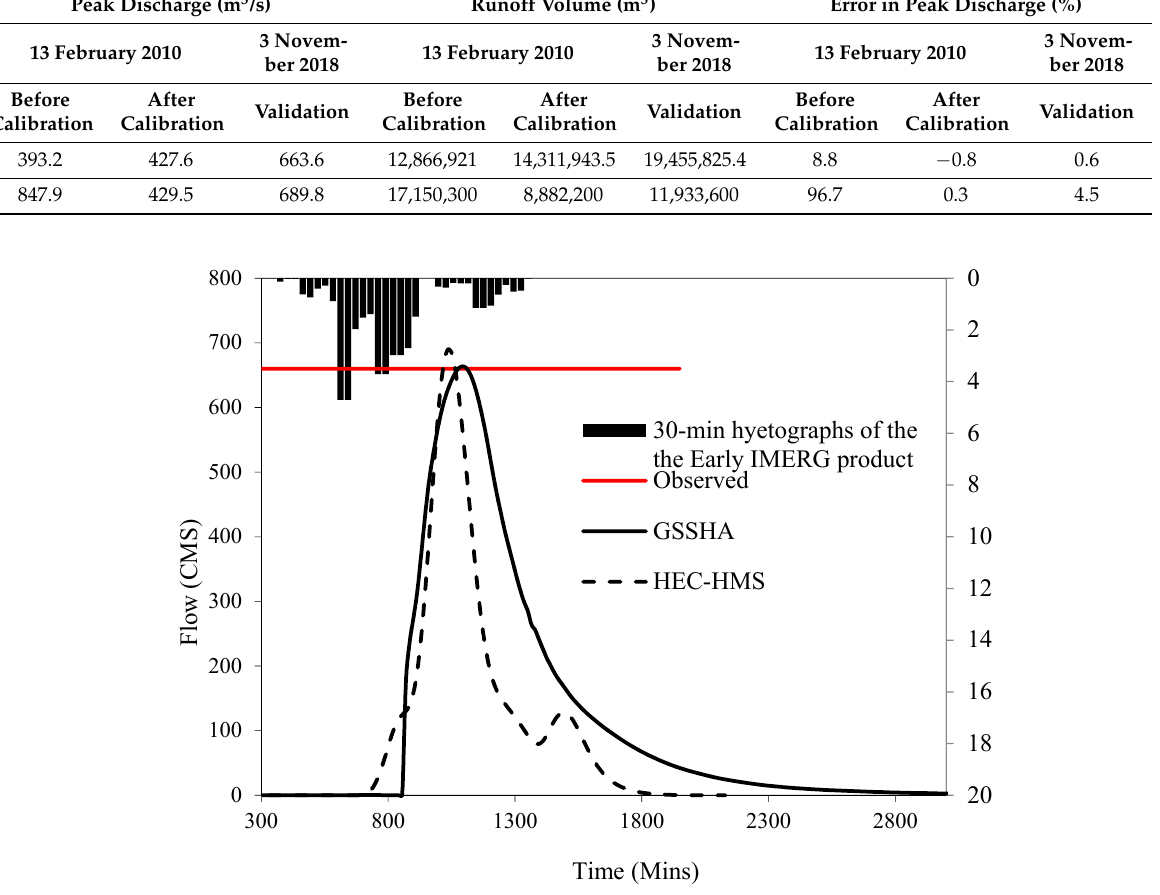
Figure 13. Comparison between simulated hydrographs for HEC-HMS and GSSHA models and observed peak discharge at the outlet of Wadi Al-Nu’man.